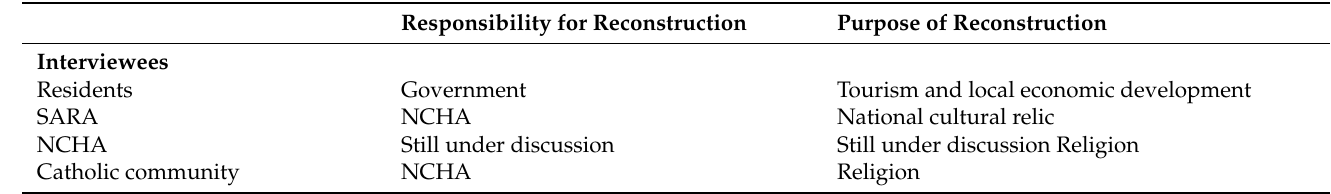
Table 3. Reconstruction Appeal of Seminarium Annunciationis